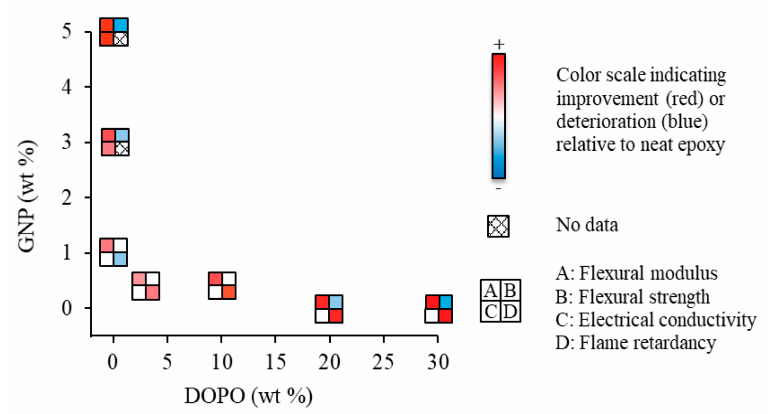
Figure 9. Comparison, with respect to neat epoxy resin, of the mechanical, electrical, and flame retarding properties of epoxy composites with di ff erent loading amounts of GNP and DOPO. Supplementary Materials: The following are available online at http: // www.mdpi.com / 2073-4360 / 12 / 10 / 2349 / s1, Figure S1: Reaction between epoxy resin (DGEBA) and DOPO, Figure S2: ATR-FTIR spectra indicating the functional groups of DOPO, neat epoxy and epoxy / DOPO mixture, Figure S3: Storage modulus (E’) and tan δ of neat epoxy resin and EP / 10DOPO obtained from DMTA, Table S1: Formulations of epoxy resin and DOPO-incorporated epoxy resin cured with polyetheramine (Je ff amine D-230), Table S2: Identification of observed peaks from FTIR spectra of DOPO, neat epoxy and epoxy / DOPO mixtures, Table S3: Electrical properties of the epoxy / GNP